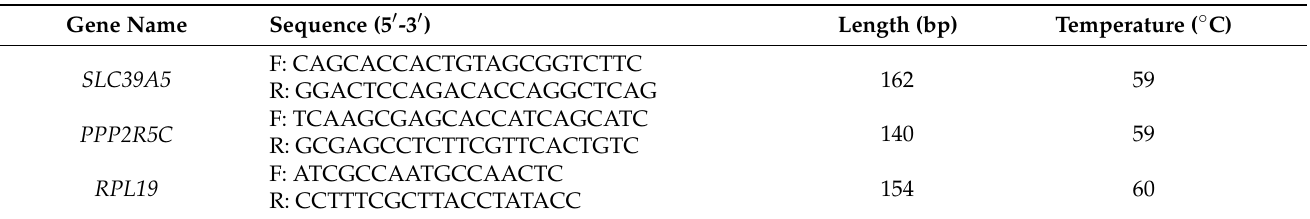
Table 4. RT-qPCR primers